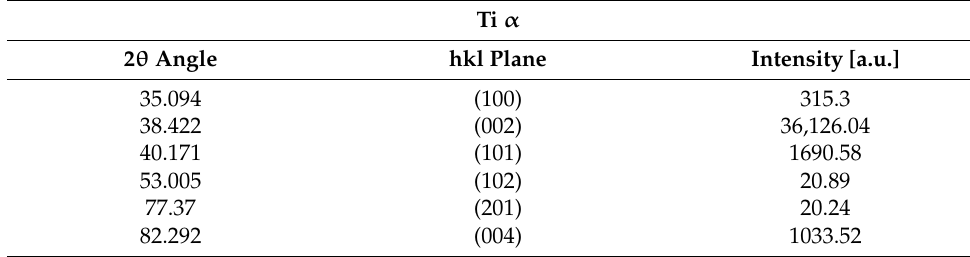
Table 2. Crystalline planes corresponding to Ti in α -phase.